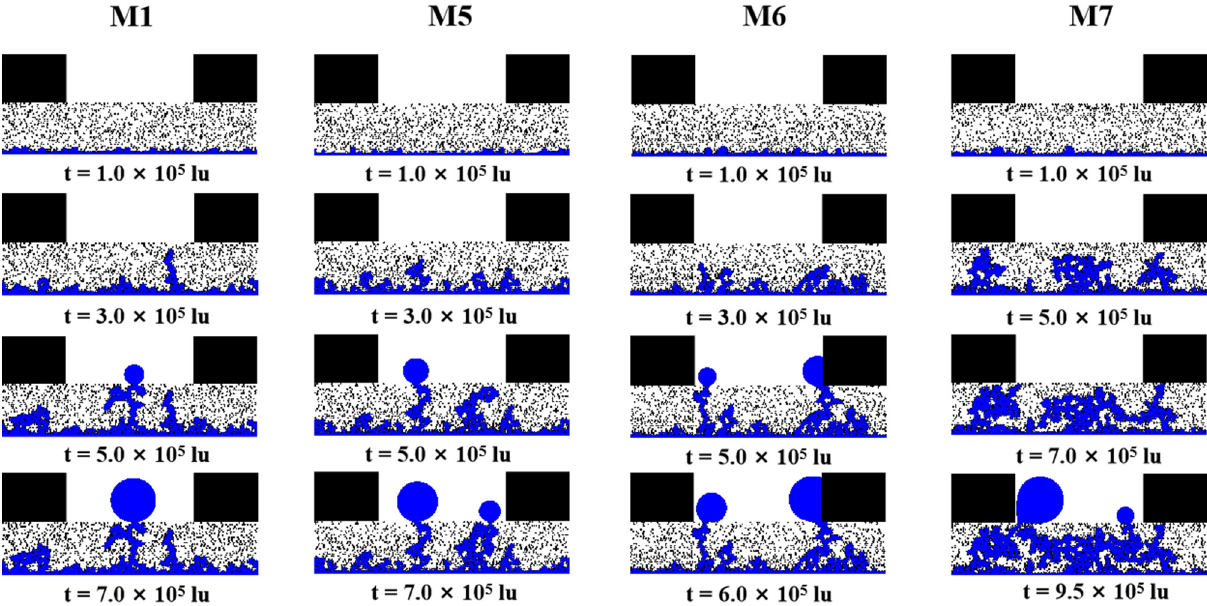
Figure 5. The liquid water distribution for M1, M5, M6, and M7 at different simulation times. The evolution of water saturation within M1, M5, M6, and M7 with time is revealed in Figure 6a. The water saturation at a steady state in M5 is not significantly lower than in M1, but the time of liquid water breakthrough is earlier. The time for liquid water to reach a steady state within M6 is 11.1% faster than M1, and water saturation is 13.4% lower, demonstrating the advantages of this structure for water management. The accumulation of liquid water in the middle region of M7 results in a significant increase in both the saturation of liquid water within M7 and the time to reach a steady state. The distribution of water saturation along the through-plane direction as liquid water reaches the steady state within M1, M5, M6, and M7 is shown in Figure 6b. Similarly, in the region where y/y GDL < 0.2, the local water saturation of M5 and M6 is smaller than that of M1, suggesting that smaller local porosity on the catalyst layer side reduces the number of dominant flow paths. The phenomenon can be observed even though the porosity gradient of M5 and M6 is smaller than that of M2 and M3. With the same volume of liquid water flowing in from the entrance area, fewer predominant flow paths mean an increased liquid water flow velocity, which explains the earlier breakthrough of liquid water within M2, M3, M5, and M6 than within M1.